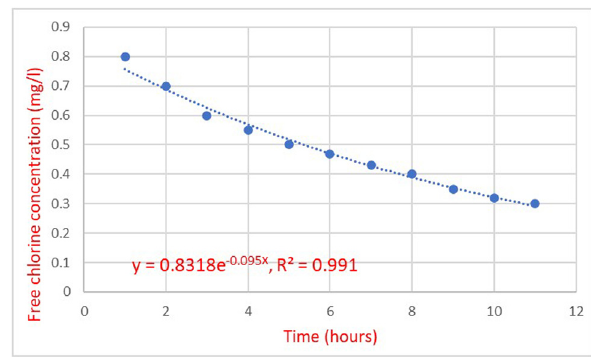
Figure 5. This procedure was done to all eight samples of water to obtain the most consistent